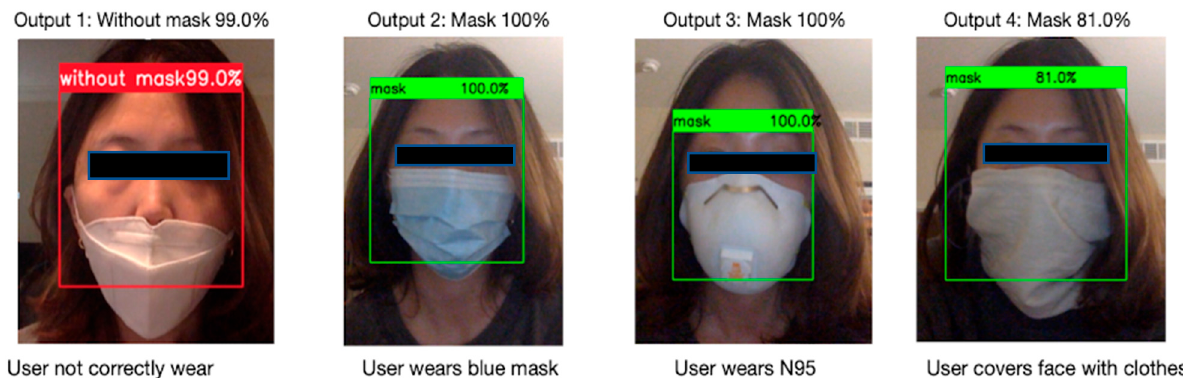
Figure 19. Face Mask Detection in different scenarios.